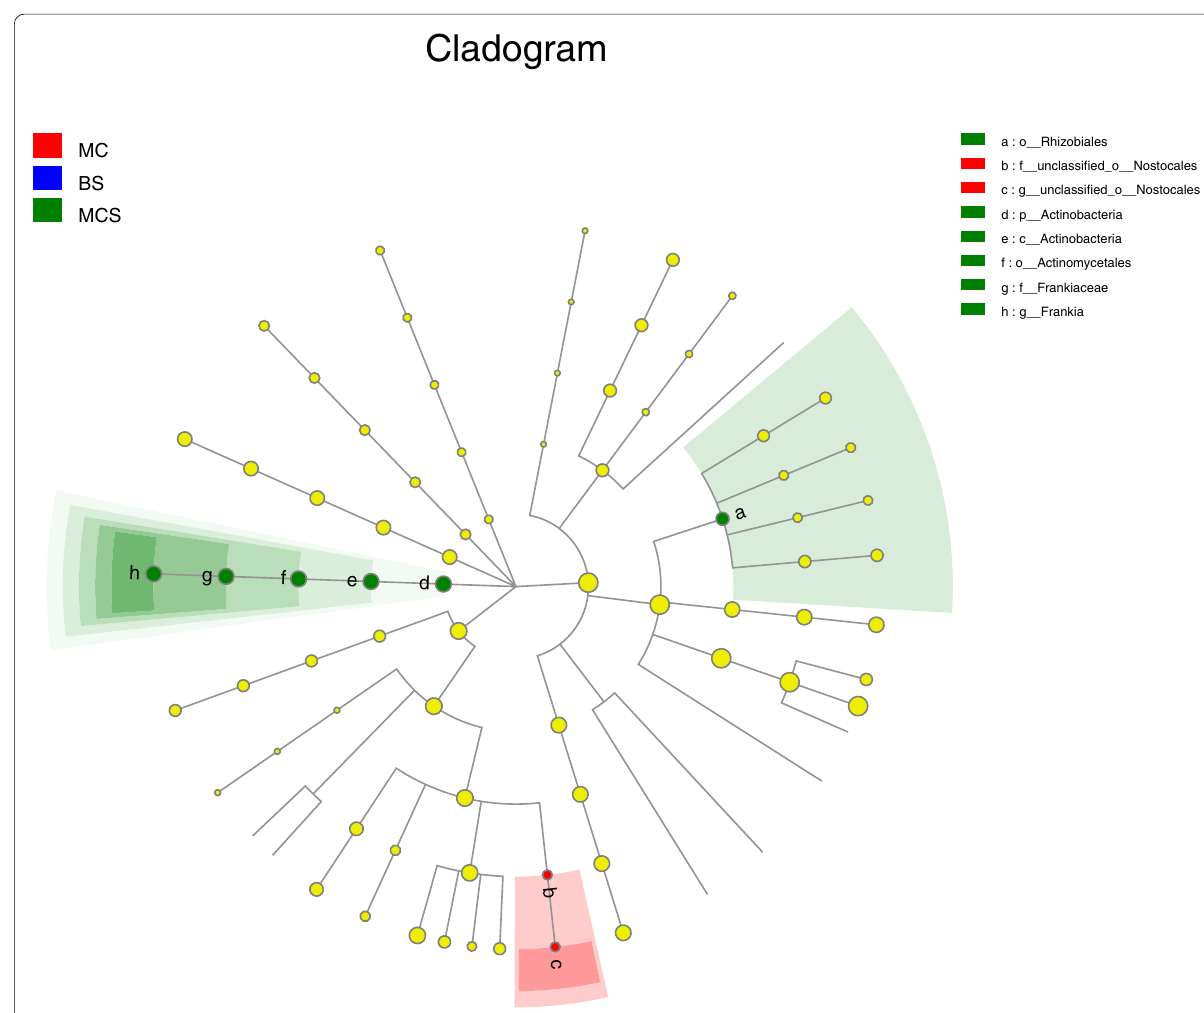
Fig. 7 LEfSe cladogram comparing communities from phylum to genus between treatment groups. Notes: MC, BS, and MCS are the same as in Fig. 1. Different color nodes represent microorganisms that are significantly enriched in the corresponding groups and have a significant impact on the differences between groups. Light yellow nodes indicate that there is no significant difference in different